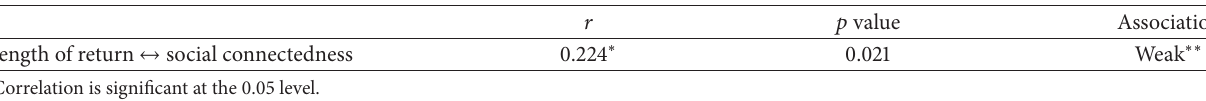
Table 3: Relationship between length of stay and social connectedness ( 𝑛 = 107 ).